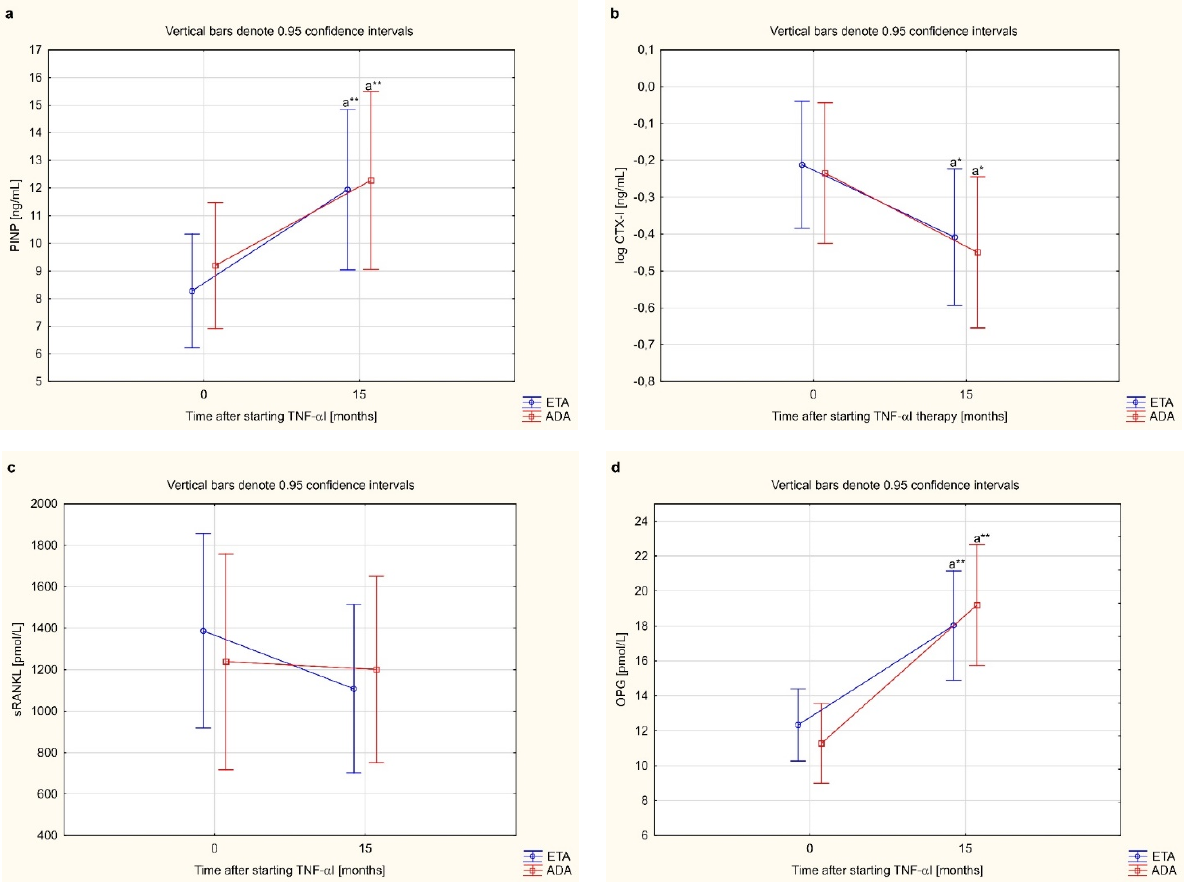
Figure 4. The effect of type TNF- α inhibitor used on serum levels of bone turnover markers, i.e. PINP ( a ), CTX-I ( b ) and osteoclastogenesis markers: sRANKL ( c ) and OPG ( d ) in female rheumatoid arthritis patients during 15-month therapy. a * p < 0.01 or a ** p < 0.001 compared to the baseline. ADA, adalimumab; CTX-I, C-terminal cross-linking telopeptides of type I collagen; ETA, etanercept; OPG, osteoprotegerin; PINP, N-terminal propeptides of type I procollagen; RA, rheumatoid arthritis; sRANKL, total soluble receptor activator of nuclear factor κ B ligand; TNF α I, tumor necrosis factor α inhibitors.